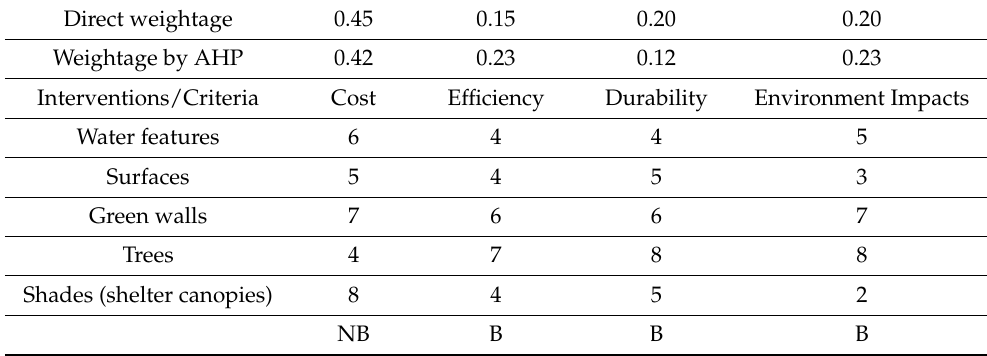
Figure 3. Research methodology.